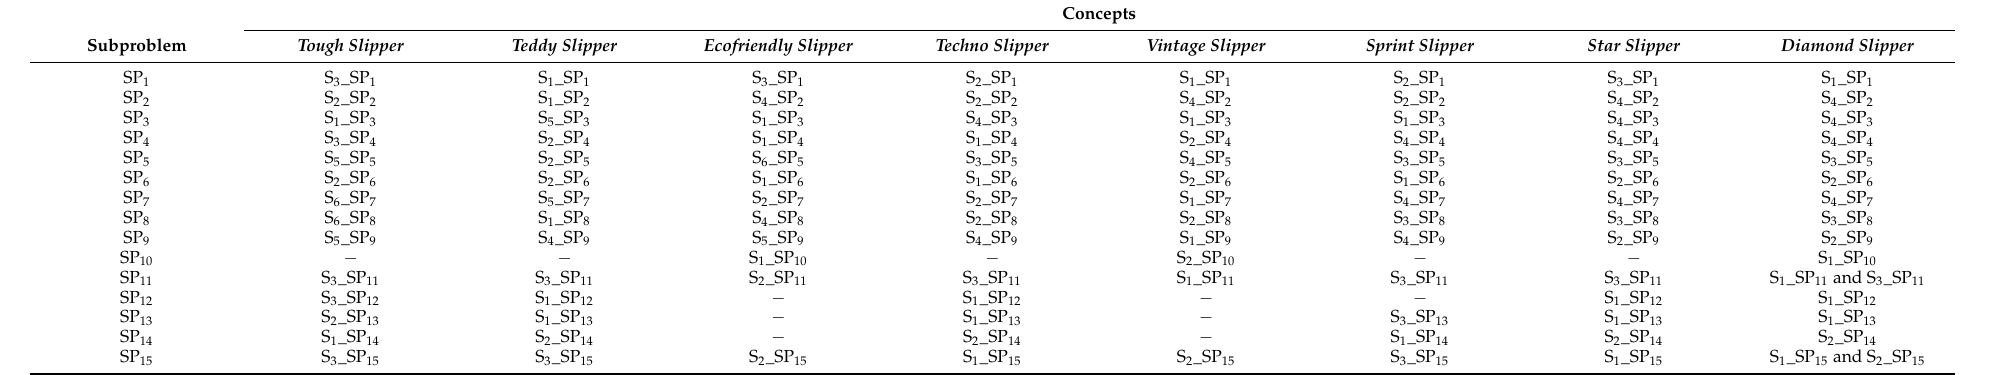
Table 12. Concepts generated by the combination of